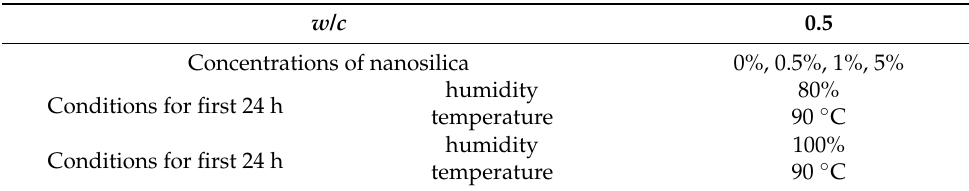
Figure 5. Autoclave samples (photo by the author). Table 1. Detailed methodology chart.